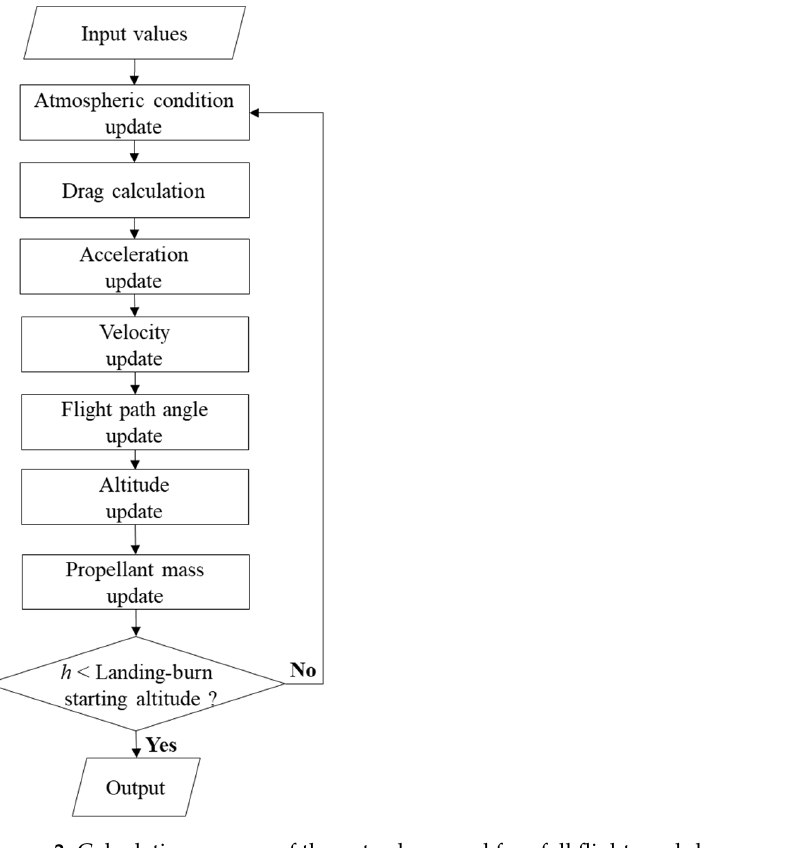
Figure 3. Calculation process of the entry-burn and free-fall flight modules.